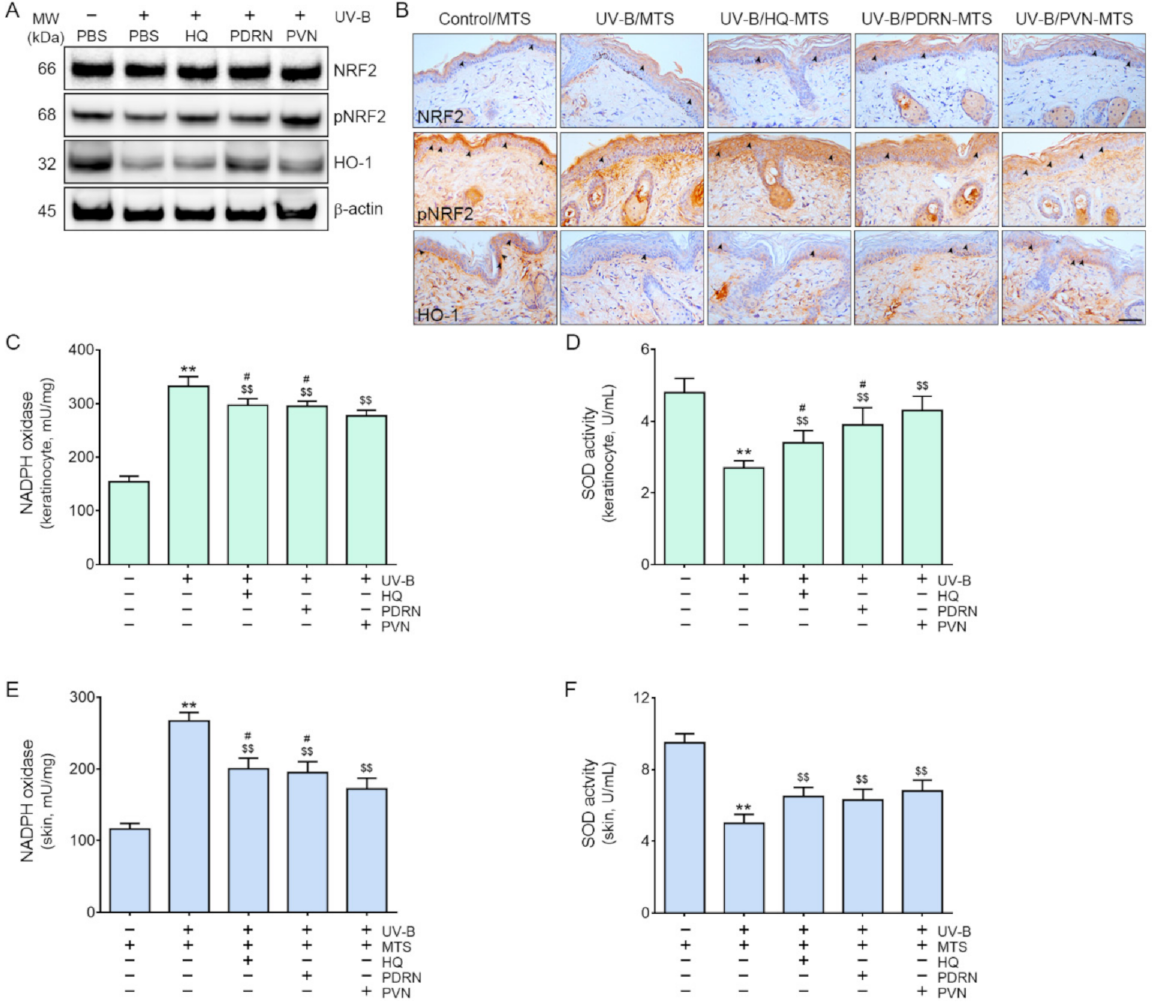
Figure 1. Regulation of the expression of NRF2 and HO-1, NADPH oxidase activity, and SOD activity by HQ, PDRN, and PVN treatment in UV-B-radiated human keratinocytes and animal skin. ( A ) Immunoblot analysis of NRF2, pNRF2, and HO-1 in human keratinocytes. ( B ) NRF2, pNRF2, and HO-1 expression in the epidermis of UV-B-radiated mice was determined by immunohistochemistry (scale bar = 100 µ m). The arrows indicated positive cells of NRF2, pNRF2, and HO-1. ( C , D ) NADPH oxidase activity ( C ) and SOD activity ( D ) were determined in the UV-B-radiated human keratinocytes. ( E , F ) NADPH oxidase activity ( E ) SOD activity ( F ) were measured in the UV-B-radiated animal skin. Data are presented as the mean ± standard deviation; **, p < 0.01 vs. first bar; $$, p < 0.01 vs. second bar; #, p < 0.05 vs. 5th bar (Mann–Whitney U test). HO-1, heme oxygenase-1; HQ, hydroquinone; MTS, microneedling therapy system; MW, molecular weight; NADPH, nicotinamide-adenine-dinucleotide phosphate hydrogen; NRF2, nuclear factor erythroid-2-related factor 2; PBS, phosphate-buffered saline; PDRN, polydeoxyribonucleotide; pNRF2, phosphorylated nuclear factor erythroid-2-related factor 2; PVN, polydeoxyribonucleotide+vitamin C+niacinamide; SOD, superoxide dismutase; UV-B, ultraviolet